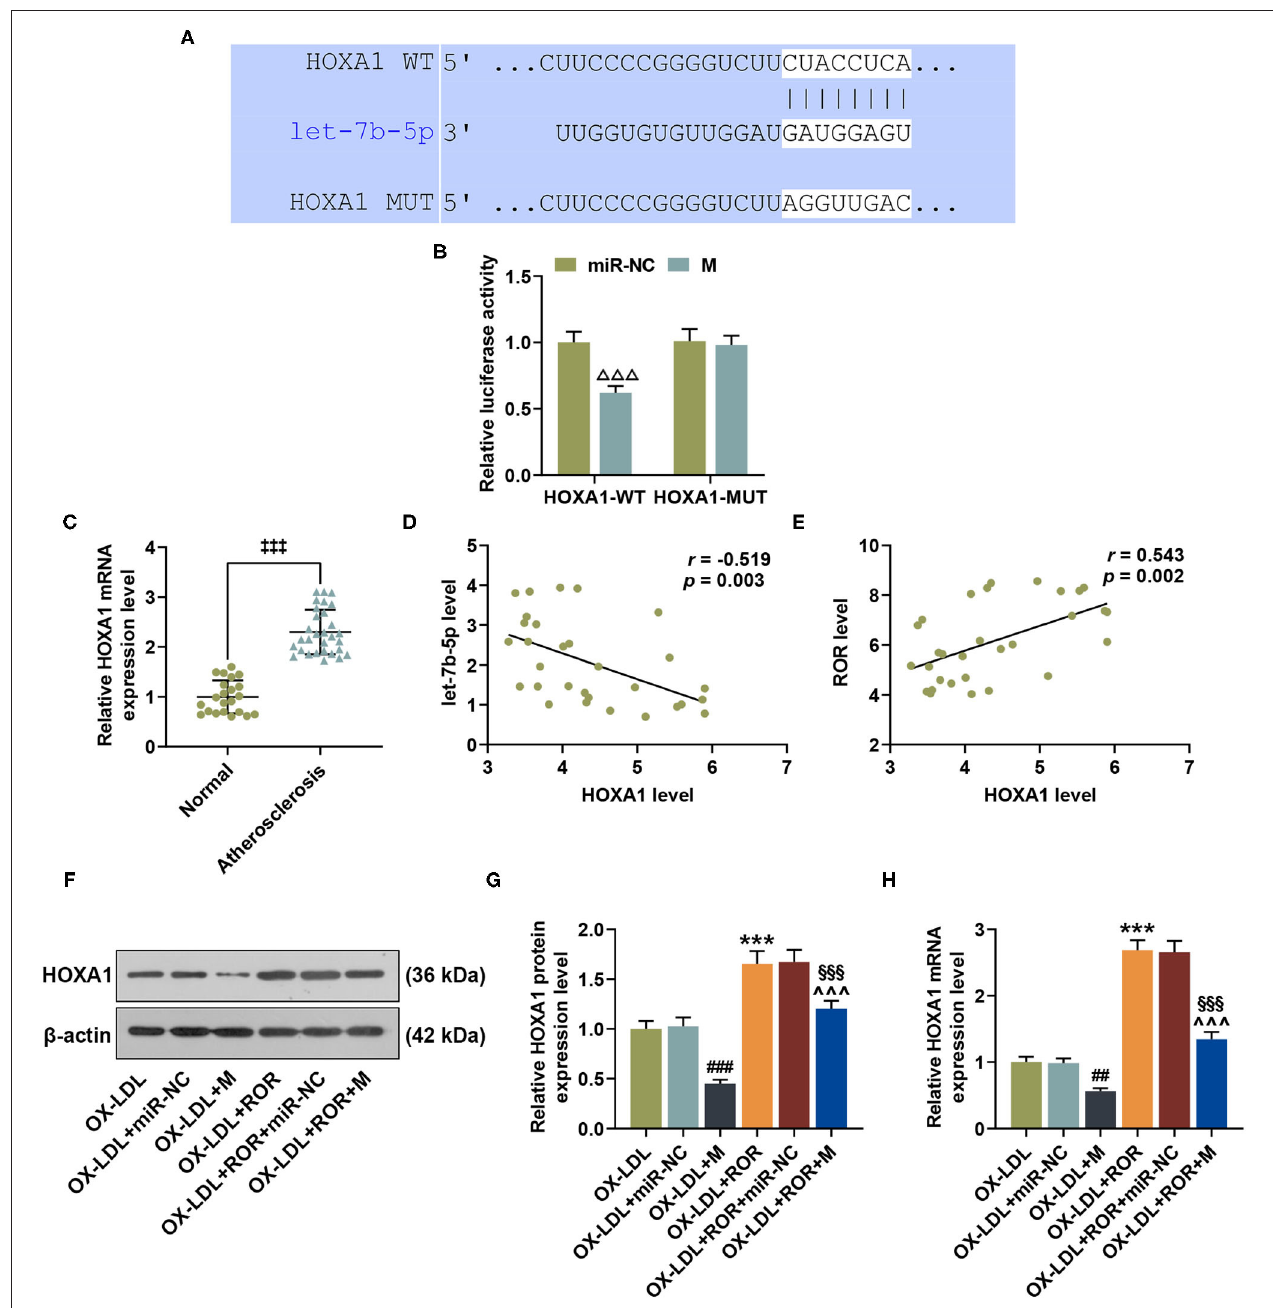
FIGURE 5 | HOXA1 was the target gene of let-7b-5p, with its expression being upregulated in atherosclerosis (AS), and let-7b-5p reversed the effects of upregulated lncRNA regulator of reprogramming (ROR) on HOXA1 expression in ox-LDL-treated HUVECs. (A) The predicted potential binding sites between let-7b-5p and HOXA1 at wild-type 3 ′ -UTR and mutated 3 ′ -UTR of HOXA1 (HOXA1-WT and HOXA1-MUT) are shown. (B) Dual-luciferase reporter assay confirmed that HOXA1 was the target gene of let-7b-5p. (C) The relative HOXA1 expressions in peripheral venous blood from patients with AS ( n = 30) and healthy donors (normal, n = 22) were measured with qRT-PCR. β -Actin was used as an internal control. (D,E) Pearson’s correlation test detected a negative correlation between HOXA1 and let-7b-5p (D) and a positive correlation between HOXA1 and lncRNA ROR (E) . (F,G) The relative protein/ β -actin expression of HOXA1 was measured by Western blot. β -Actin was used as an internal control. (H) The relative mRNA expression of HOXA1 was measured by qRT-PCR. β -Actin was used as an internal control. All experiments have been performed independently in triplicate, and data were expressed as mean ± standard deviation. Statistical significance was assessed by paired t -test and one-way ANOVA, followed by Tukey’s post-hoc test. A correlation analysis of lncRNA ROR, let-7b-5p, and HOXA1 was performed using Pearson’s correlation test. 111 P < 0.001 vs . miR-NC; ‡‡‡ P < 0.001 vs . normal; ## P < 0.01, ### P < 0.001 vs . ox-LDL + miR-NC; *** P < 0.001 vs . ox-LDL; ∧∧∧ P < 0.001 vs . ox-LDL + M; §§§ P < 0.001 vs . ox-LDL + ROR + miR-NC. HOXA1, homeobox A1; 3 ′ -UTR, 3 ′ -untranslated